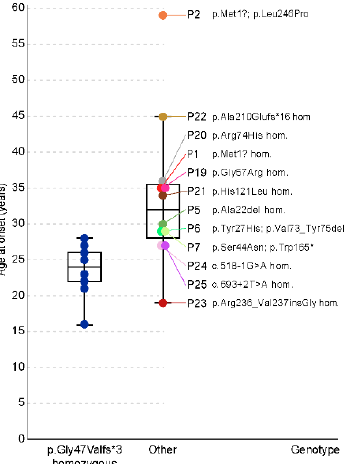
Figure 5. Disease onset in patients harboring homozygous variant p.Gly47Valfs*3 (baseline group) compared with the other patients. Note the significantly earlier median age of onset in the baseline group. Other patients had very variable disease onsets i.e., Patient 2 (p.Met1?; p.Leu246Pro) at the age of 59 years, Patient 22 (p.Ala210Gluufs*16 homozygous) at the age of 45 years and Patient 23 (p.Arg236_Val237insGly homozygous) at the age of 19 years. Note that all patients with pathogenic variant p.Gly47Valfs*3 are in the blue color. The colors of the patients are the same in Figures 5–8. The median BCVA at first exam (N = 25) (median age 34; range 19–61 years) in the better eye was 0.4 Snellen decimal (range 0.005–1.0) or 0.4 (range 0–2.3) LogMAR (Figure 6). The median BCVA at the last exam (N = 18) (median age 41; range 24–63 years) was 0.1 Snellen decimal (range 0.005–0.6) or 1.0 (range 0.2–2.3) LogMAR (Figure 6).